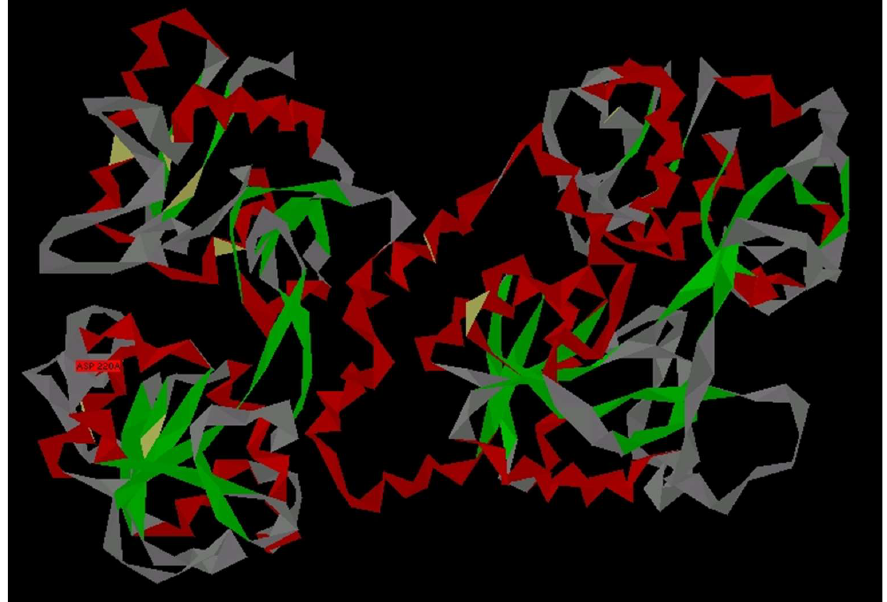
Figure 1. General view of human LF as a paper model (file 1B0L at PDB) obtained by rendering using Protein 3D software. α-Spiral parts (red); β-structures (green); left (N-lobe); and right (С-lobe).